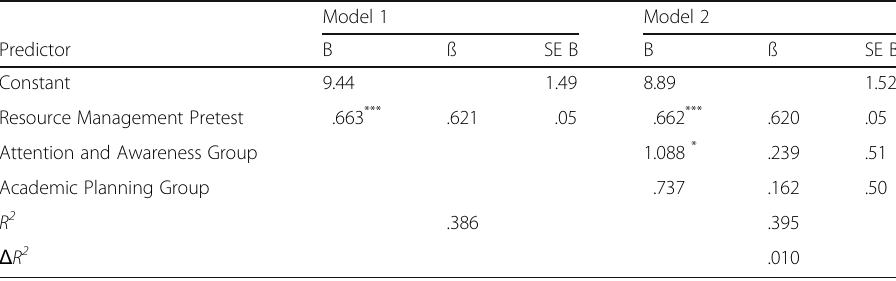
Table 6 Resource management post